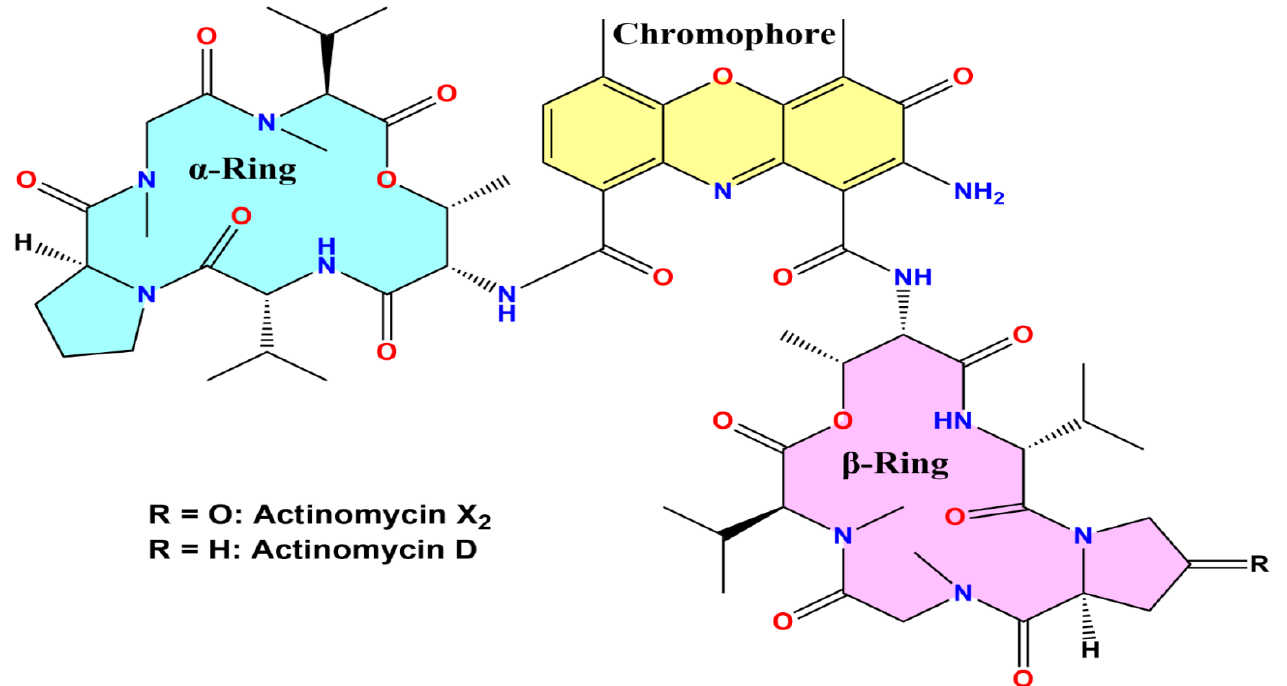
Figure 3. Structure of isolated actinomycin X 2 and actinomycin D.